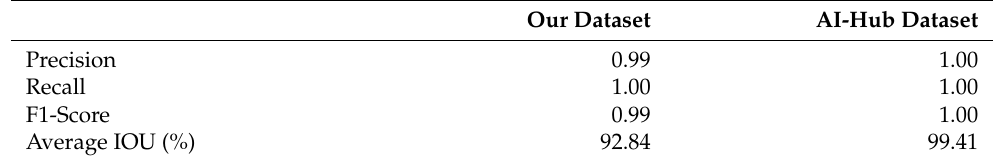
Table 10. Performance of the LPC detector.